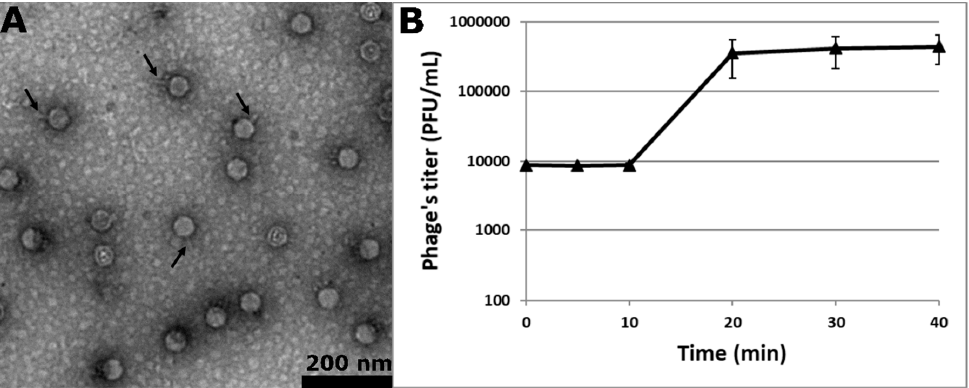
Figure 1. Characterization of the virulent phage Idefix. ( A ) Electron micrograph of Idefix particles negatively stained with 2% uranyl acetate (some Idefix tails are shown by arrows). ( B ) One step growth kinetic of phage Idefix determined in its host strain E. faecalis pp − . The values indicate the means and standard deviations of three independent experiments.